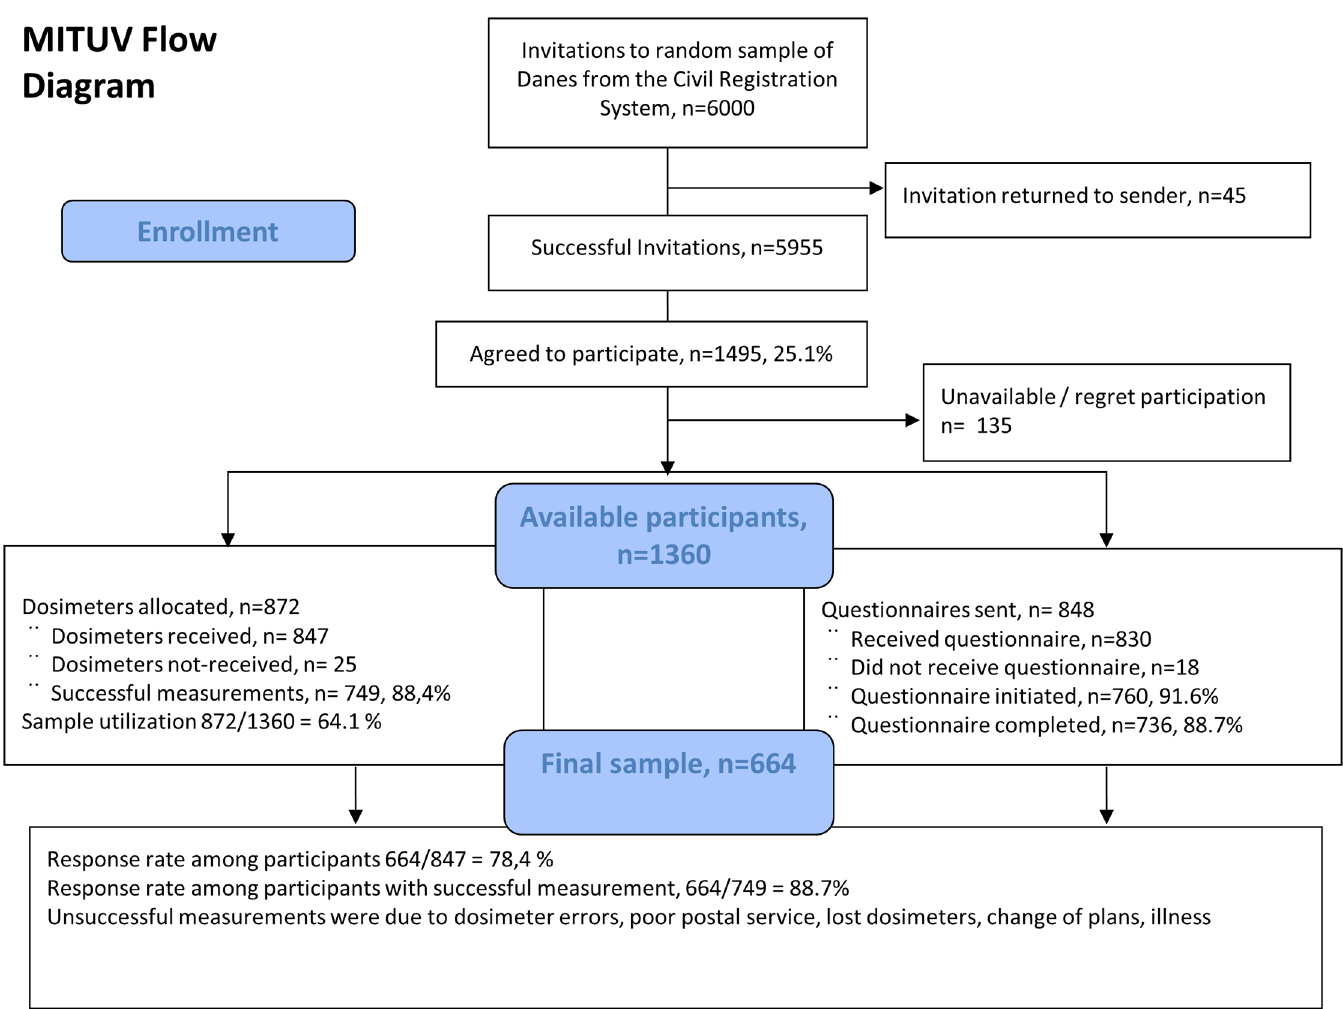
Fig 1. In the figure is shown the flow of participants in the project including participation and completion of uv-measurement and